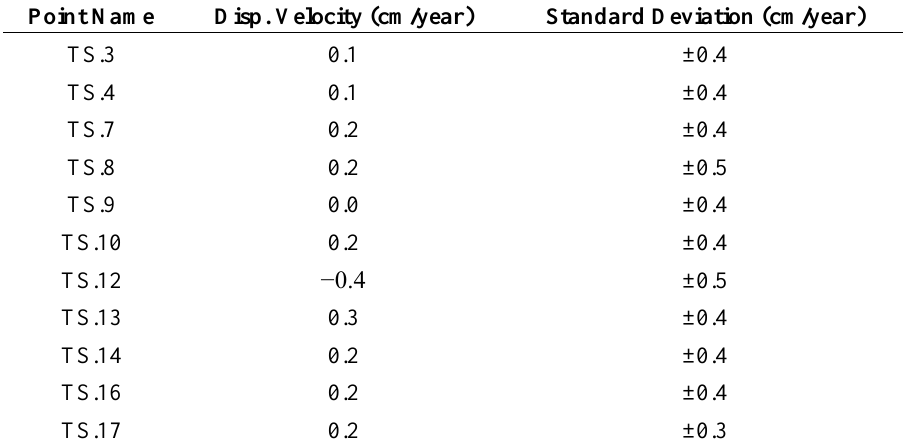
Table 2. Statistical results that were extracted from InSAR time-series analysis, which was applied for selected points in Figure 9b (displacements are in the line-of-sight (LOS)